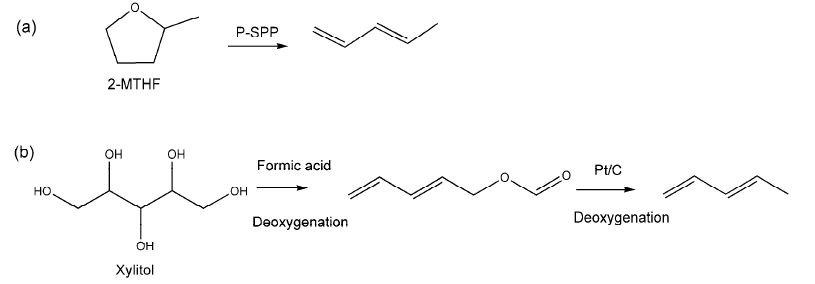
Figure 6. Synthesis of 1,3-pentadiene from 2-methyltetrahydrofuran (2-MTHF) ( a ) and Xylitol ( b )